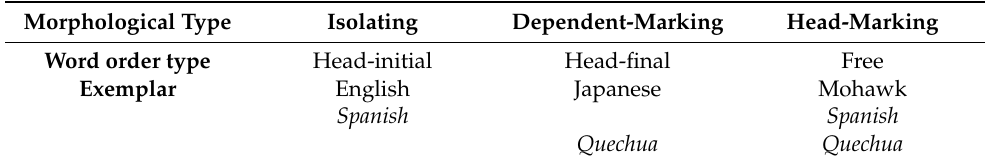
Table 1. Typology of the world’s languages. Chart adapted from Baker (1996, pp. 4–5), with Spanish and Quechua superimposed in